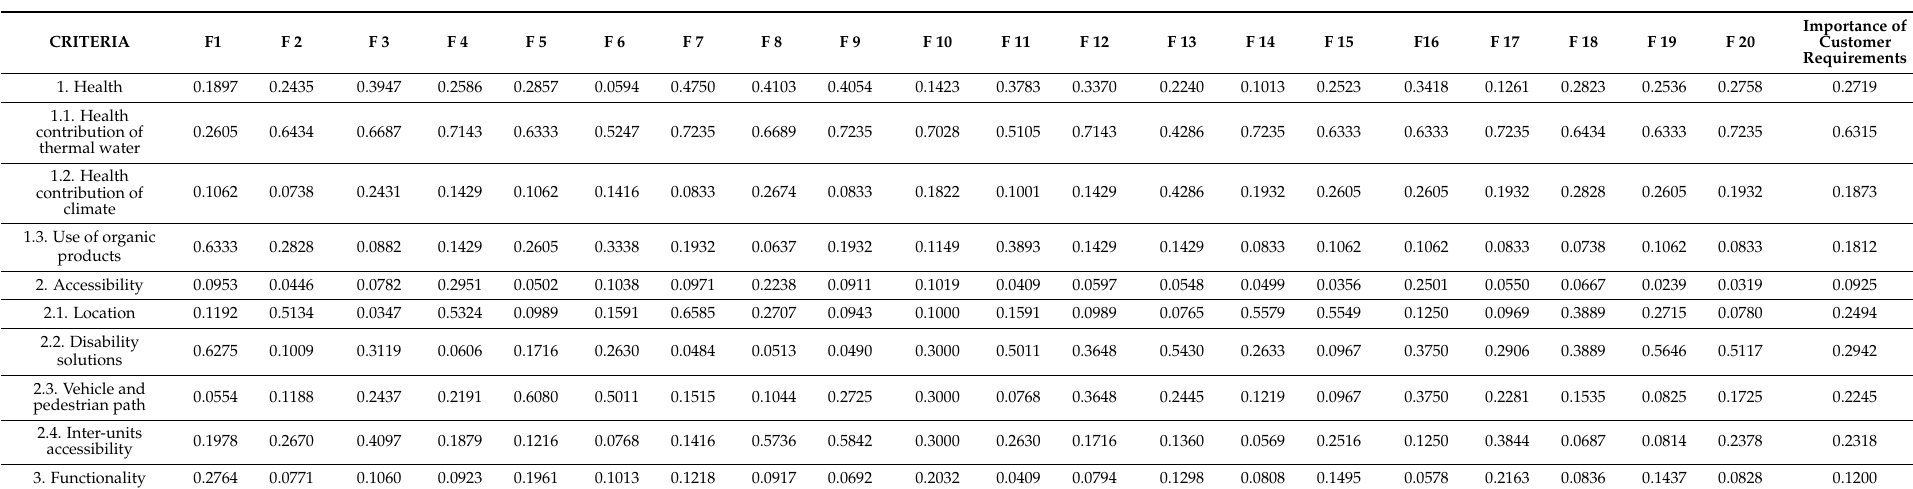
Table 5. Importance of customer requirements (f =